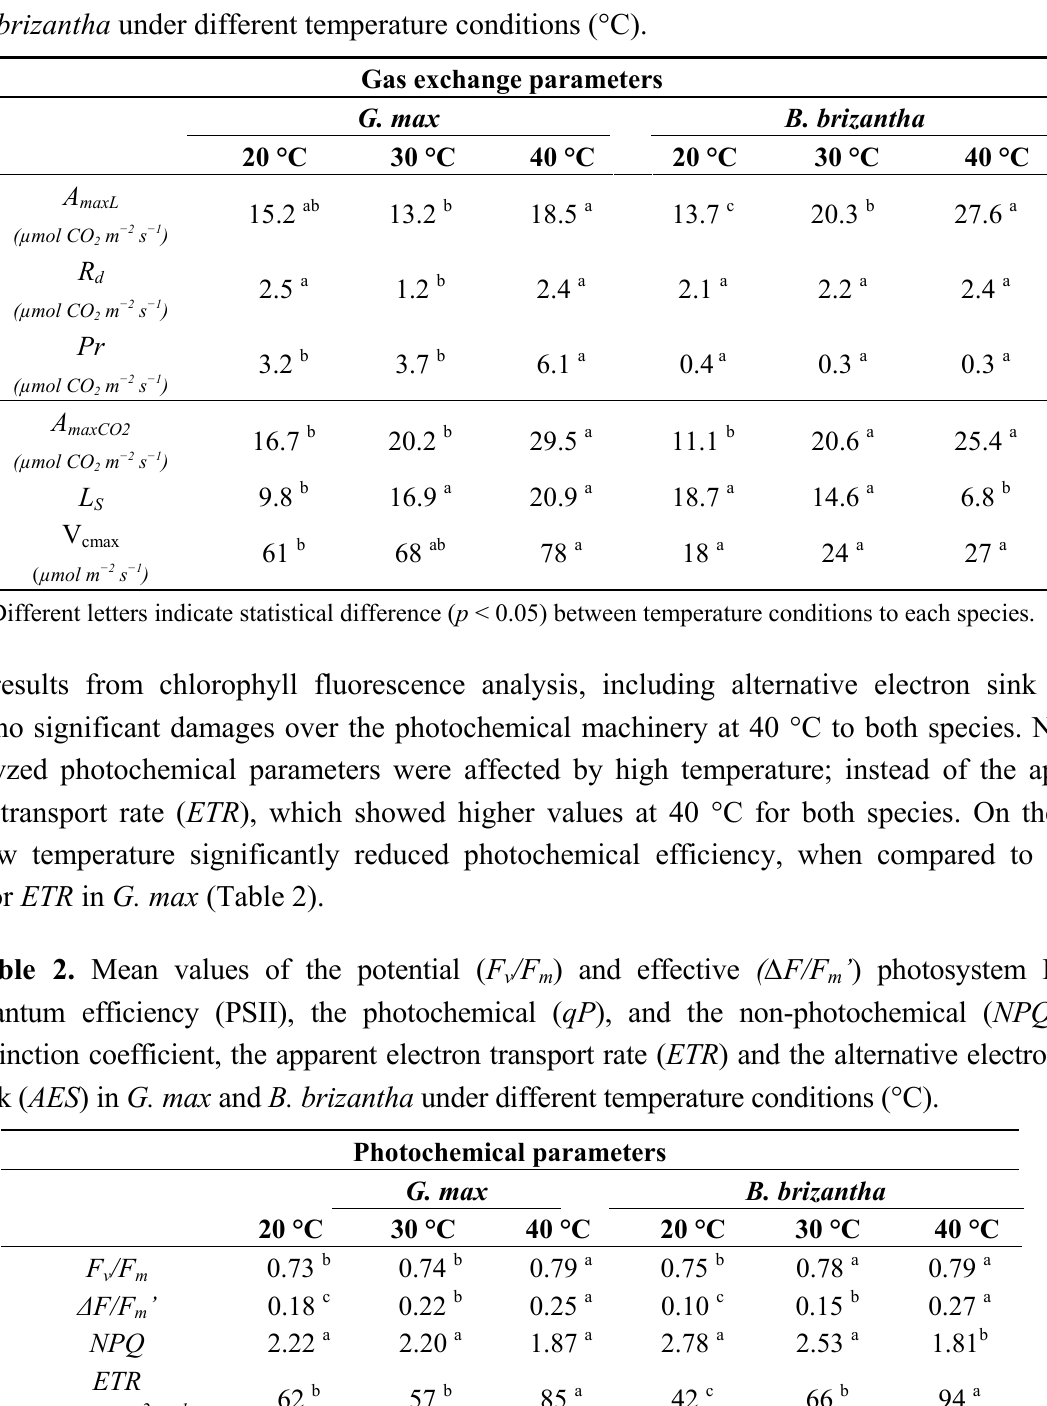
), dark respiration ( R ), maxL d ), relative stomatal limitation to maxCO2 ) in G. max and cmax